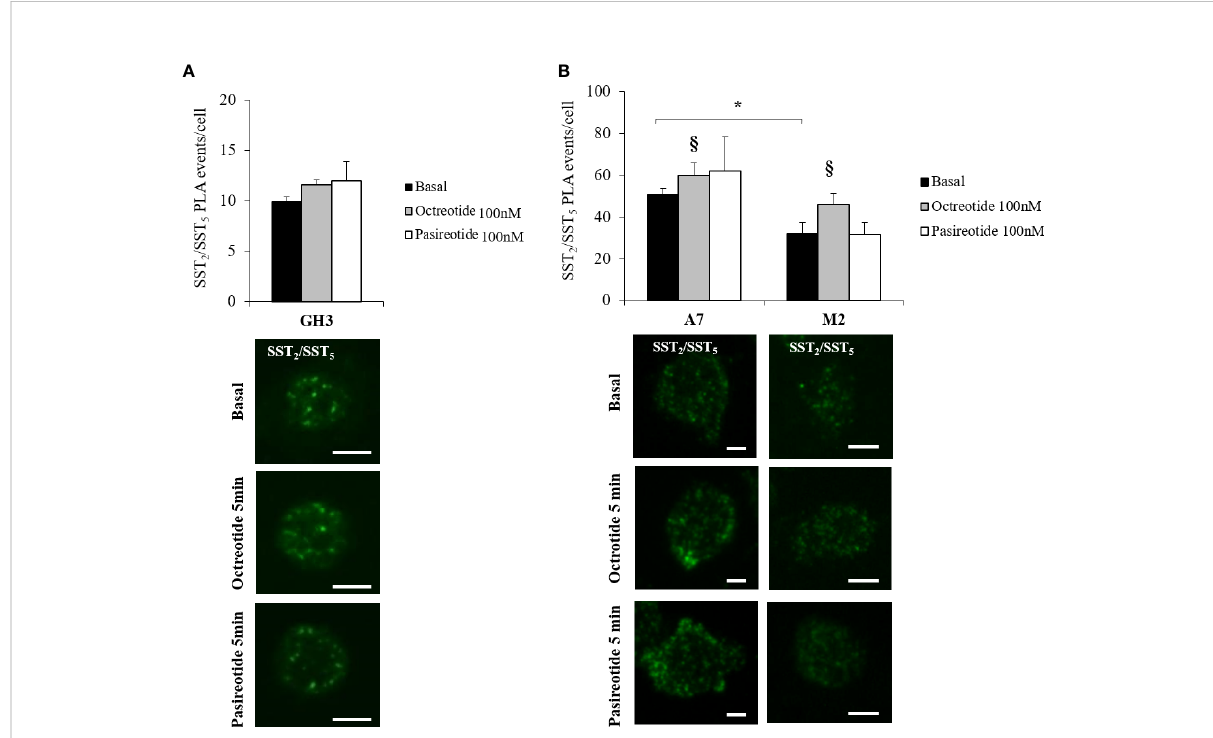
FIGURE 2 In situ detection of SST2/SST5 hetero-dimers. Representative in situ PLA experiment showing SST 2 /SST 5 hetero-dimers in GH3 (A) and melanoma cells (B) before and after treatments with 100 nM octreotide or pasireotide for 5 min. Rabbit anti-SST 2 and mouse-anti SST 5 antibodies were used. Green dots represent PLA events and indicate close proximity between SST 2 and SST 5 . Graphs resulting from the quanti fi cation of total SST 2 /SST 5 puncta representing PLA events are shown for each cell line. For (B) , a reduction in basal SST 2 /SST 5 hetero-dimers in M2 cells compared to A7 cells and an increase in SST 2 /SST 5 hetero-dimers in A7 and M2 cells treated with octreotide compared to basal are shown (n = 3, number of PLA puncta per cells was quanti fi ed for 150 cells randomly chosen from different fi elds per condition, *p < 0.05 vs . basal A7 cells; § p < 0.05 vs . corresponding basal). Scale bars: 10 m